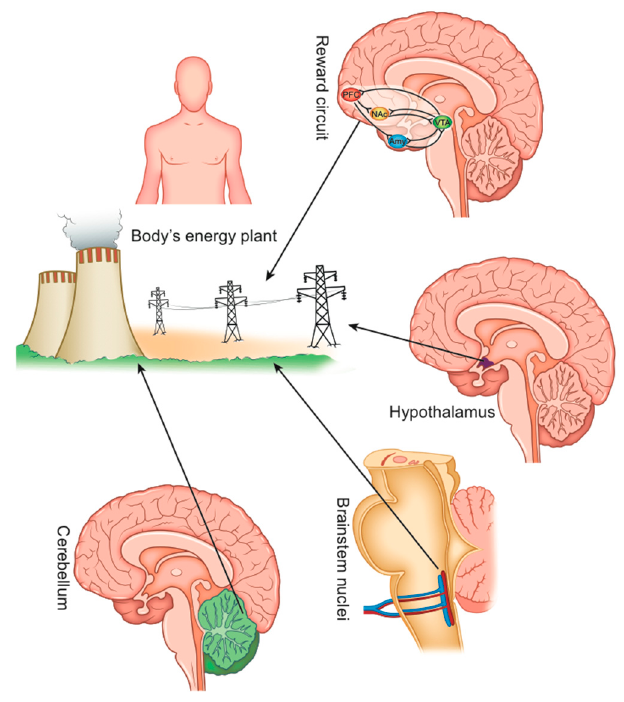
Figure 2. The main sectors of the CNS that control the body’s energy homeostasis.